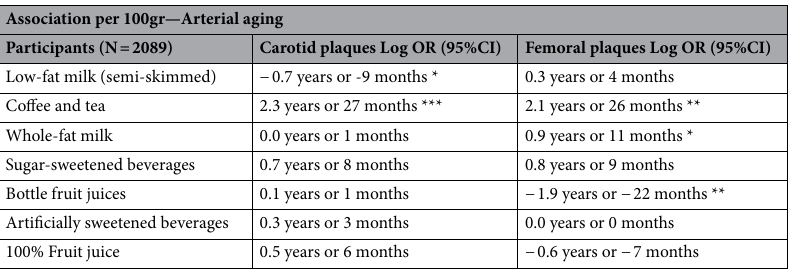
Table 3. Association between 100 g/d of beverages consumed and arterial aging among participants in the AWHS. AWHS, Aragon Workers’ Health Study; OR, odds ratio; CI, confidence interval. N, total number of participants. Asterisks denote P value: *** p ≤ 0.001, ** p ≤ 0.01, * p ≤ 0.05. † Adjusted for age, BMI, smoking